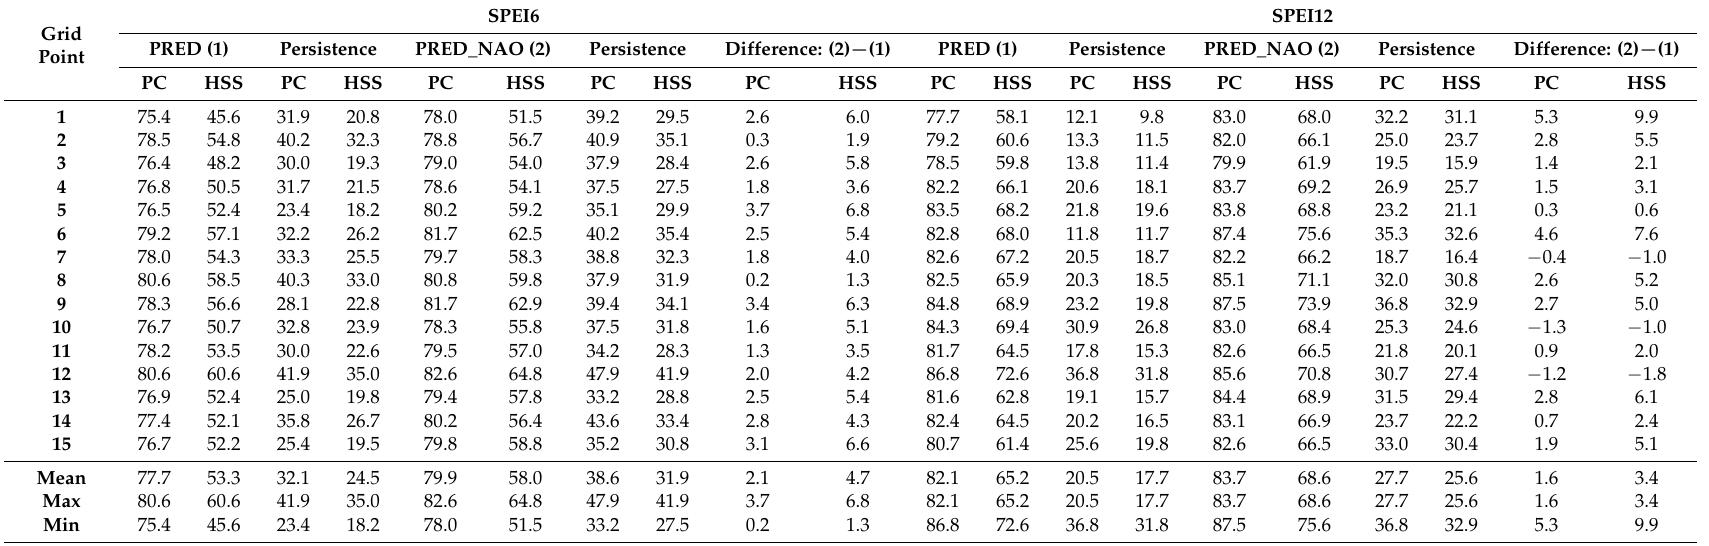
Table 8. Proportion correct (PC) and Heidke skill score (HSS) (%) for the SPEI6 and SPEI12 modeling in the extended winter months for PRED (1) and its fractional improvement over the persistence forecast; for PRED_NAO (2) and its fractional improvement over the persistence forecast; and for the difference between both modeling